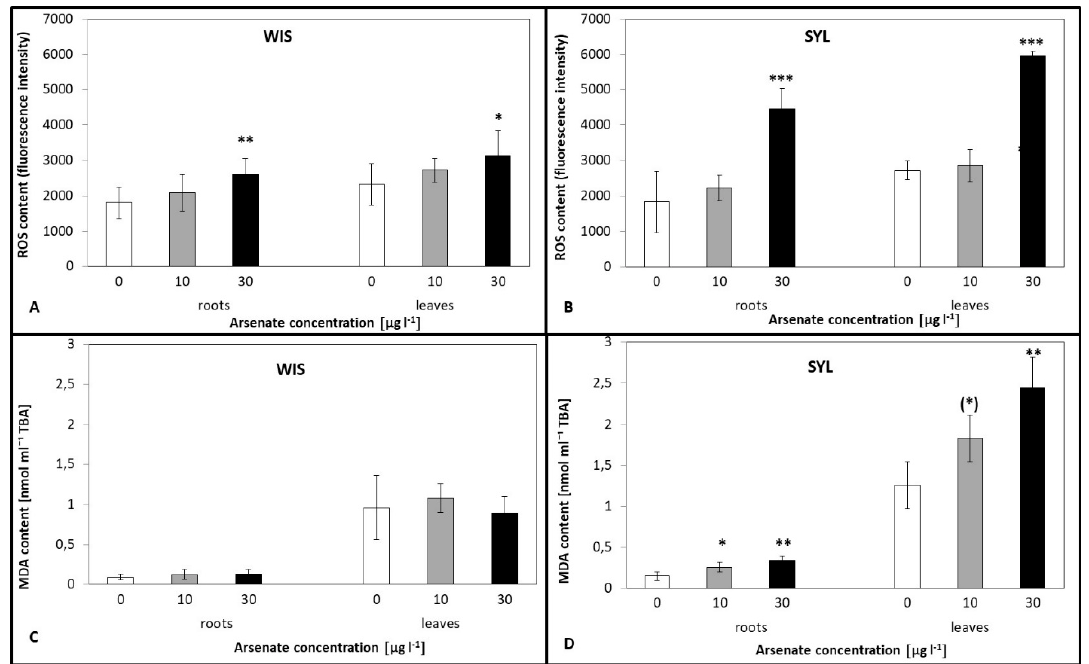
Figure 3. Effect of arsenic on the ROS ( A,B ) and malondialdehyde (MDA) ( C,D ) contents in two contrasting tobacco genotypes ( A,C tolerant N.tabacum , cv.Wisconsin; B,D sensitive N. sylvestris ). 0, 10, and 30 µg l -1 arsenate treatments. Bars indicate standard deviations. Stars mean statistically significant differences from control at the level α = 0.1 ((*)), 0.05(*), 0.01 (**) or 0.001(***), n = 5–9.